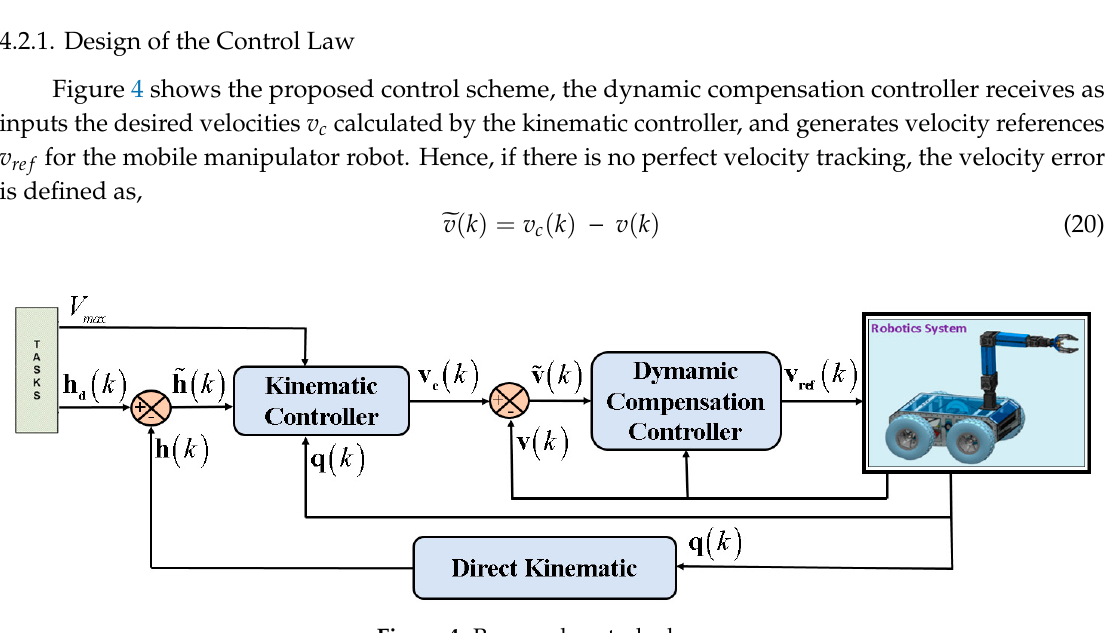
Figure 4. Proposed control scheme.